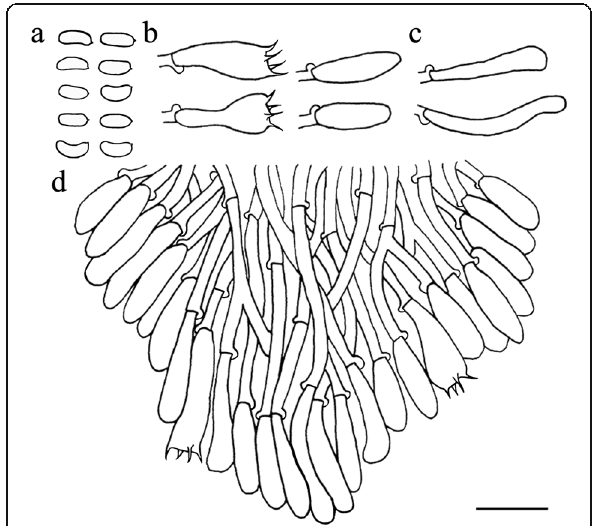
Fig. 9 Microscopic structures of Skvortzovia dabieshanensis (drawn from holotype). a basidiospores. b basidia and basidioles. c leptocystidia. d apical part of a tooth. Scale bar = 10 μ